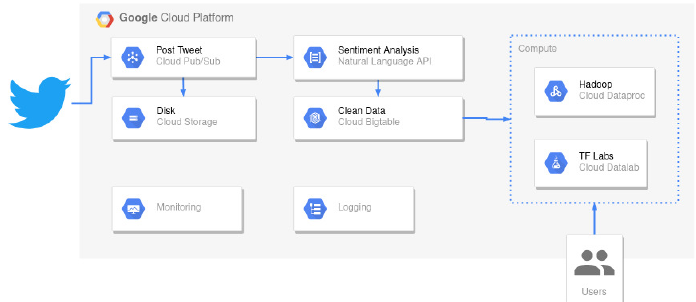
Figure 2. General Architecture implemented in Google Cloud Platform (GCP) [2]. This cloud-based architecture ingests tweets using the official Twitter APIs, sending each one of these through Google’s Pub/Sub , which uses as endpoints essential preprocessing, raw storage, and a serverless function to calculate the sentiment polarity. This function’s results are fed into BigTable through another Pub/Sub